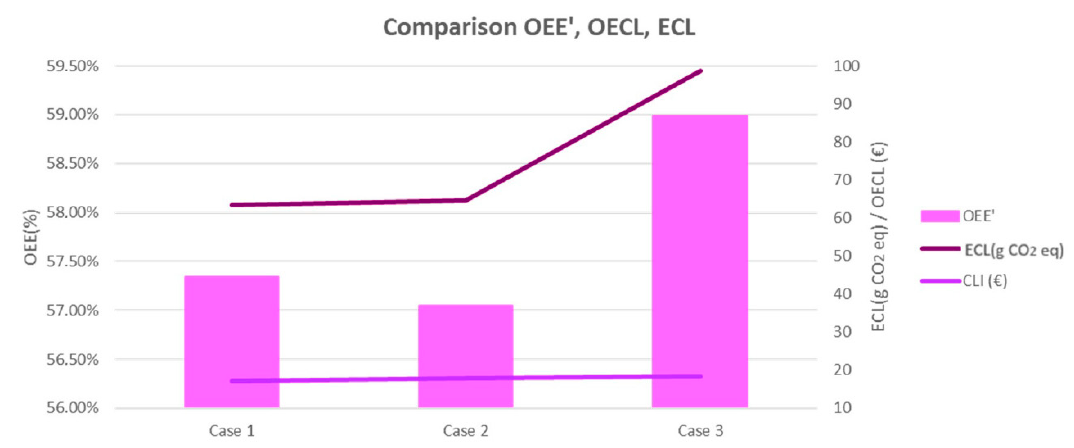
Figure 11. Comparison between OEE’, ECL, and new KPI.